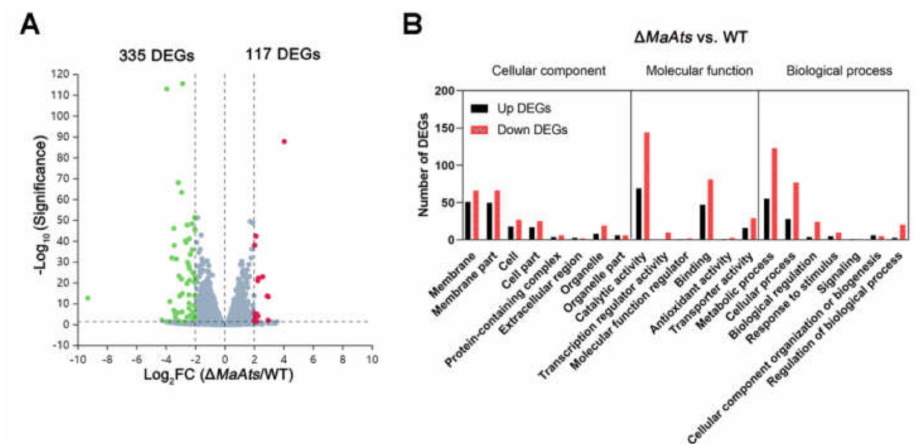
Figure 6. Identification and GO annotation of DEGs. ( A ) Identification of DEGs in the 3-day-old conidia from the ∆ MaAts vs. WT. Green dots, down-regulated genes (log 2 ratio ≤ 1). Red dots, up-regulated genes (log 2 ratio ≥ 1). Grey dots, not differentially regulated ( − 1< log 2 ratio < 1). ( B ) GO annotation of DEGs in the 3-day-old conidia from the ∆ MaAts vs.